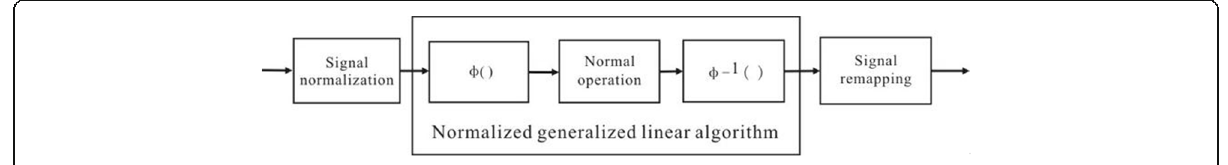
Fig. 2 Construction of surface roughness detection model